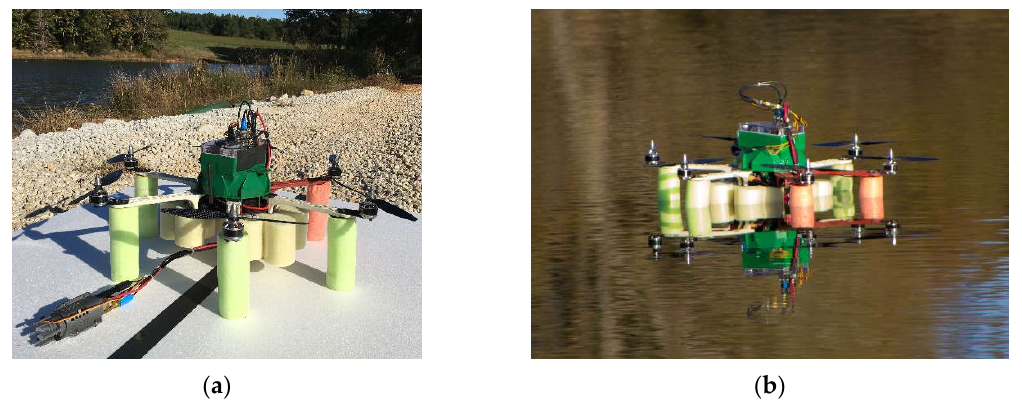
Figure 1. The unmanned aerial vehicle-assisted measurement system (UAMS): ( a ) prior to a flight mission; ( b ) floating on a water surface while making measurements.